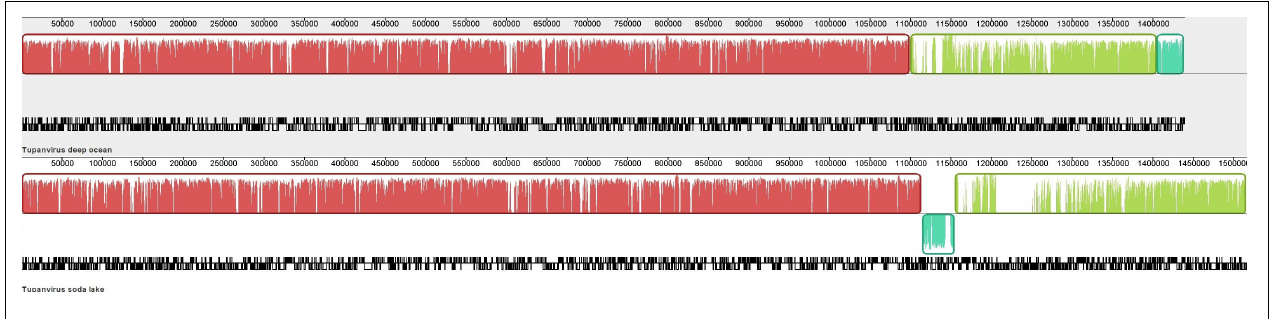
FIGURE 1 | Whole genome alignment of Tupanviruses by MAUVE software (Darling et al., 2004). The locally collinear blocks (LCB) are colored and the coding density are in black/white under the LCB.